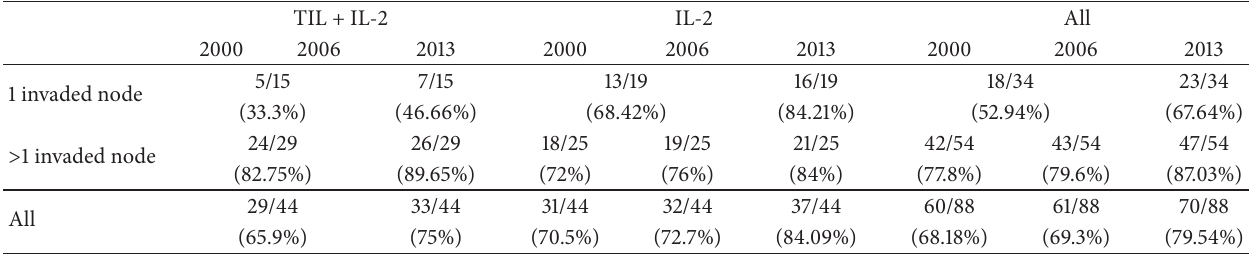
Table 2: Proportion of relapse according to the treatment and number of invaded nodes (1 or > 1). Data obtained in June 2000, April 2006, and March 2013.